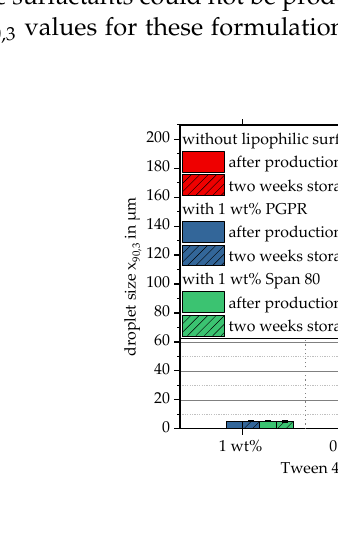
Figure 6. Changes in droplet size over storage time for O/W emulsions ( a ) and W/O/W emulsions ( b ) with the same W 2 and O phases. On the x-axis, the concentration of Tween 40 is varied. In the oil phase, either PGPR, Span 80 or no lipophilic surfactant were added. Double emulsions without lipophilic surfactant could not be produced, since they would instantly result in single emulsions; therefore, they are not shown.